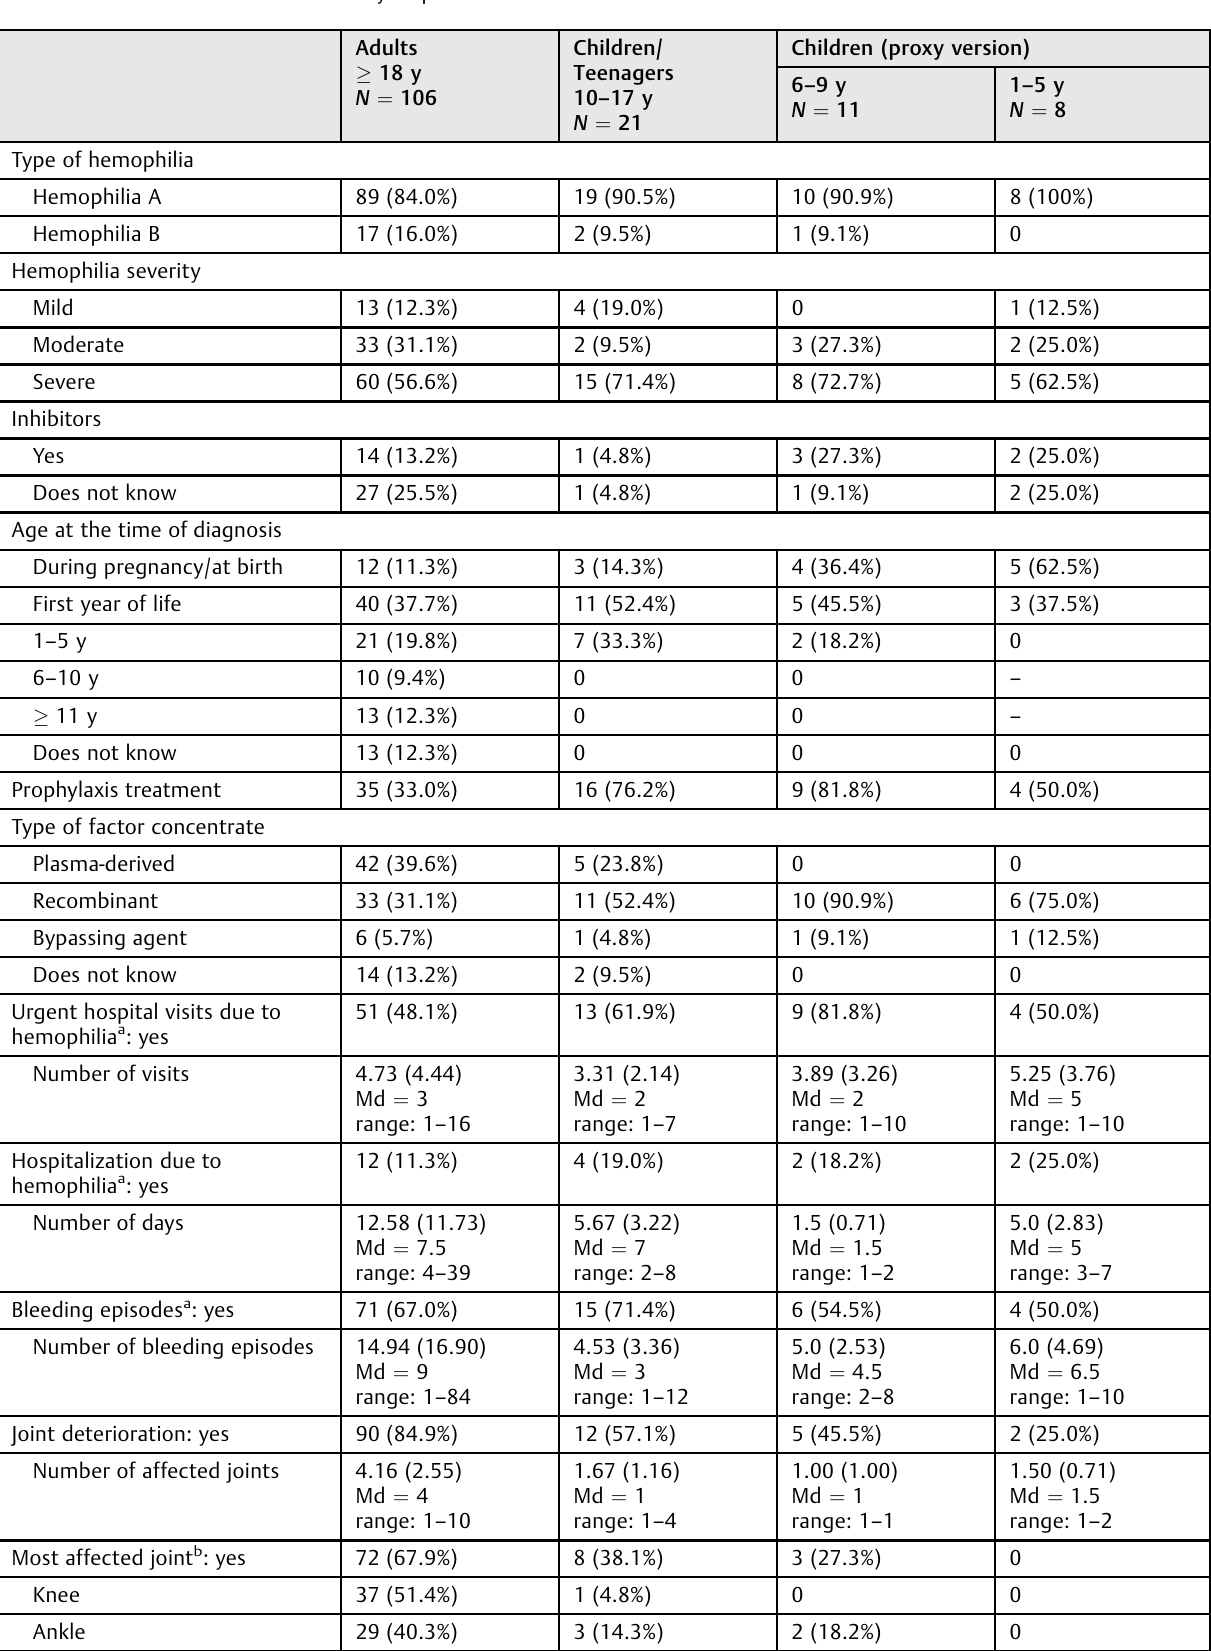
Table 3 Clinical characteristics of survey